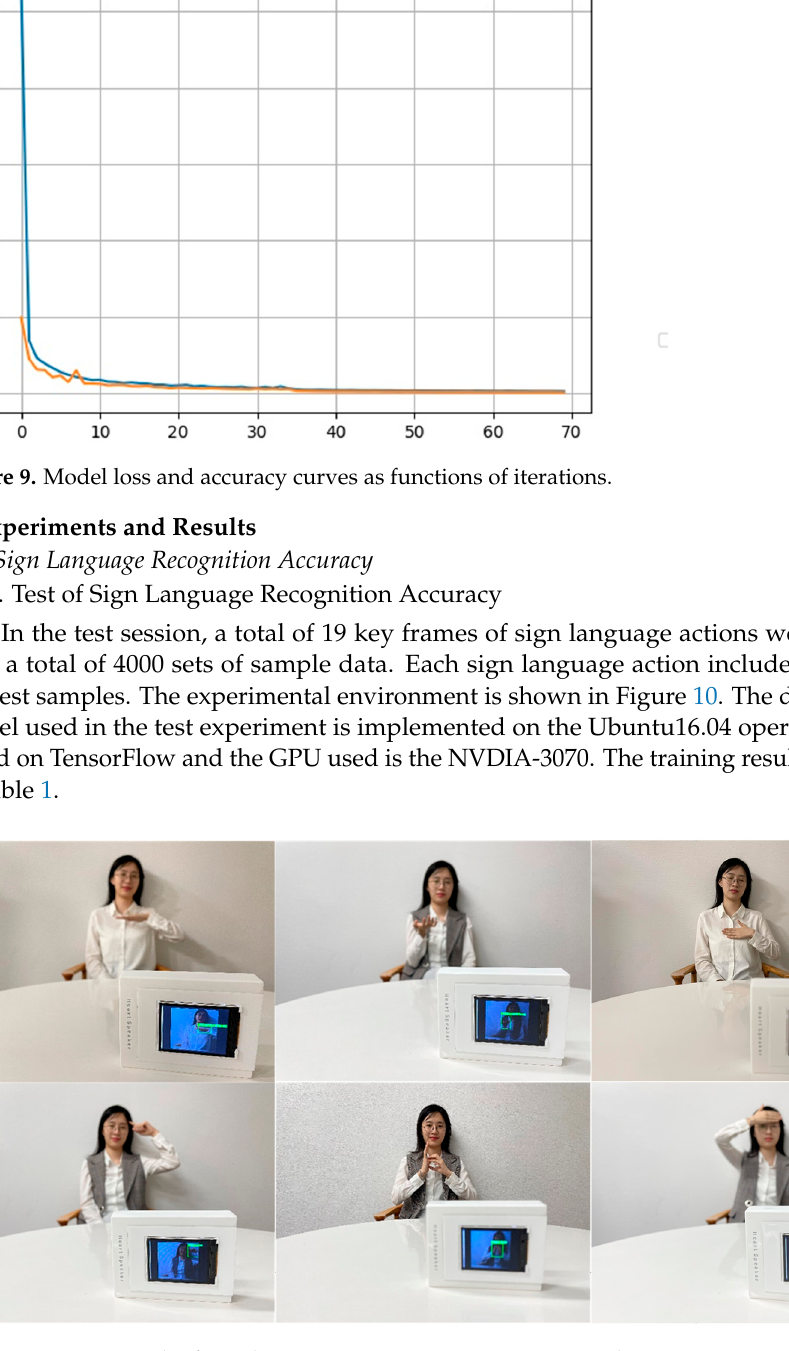
Figure 10. Scene graph of sign language recognition accuracy test. The environment was chosen in a room that mimics the decor of a hospital. Table 1. The accuracy of sign language word recognition.